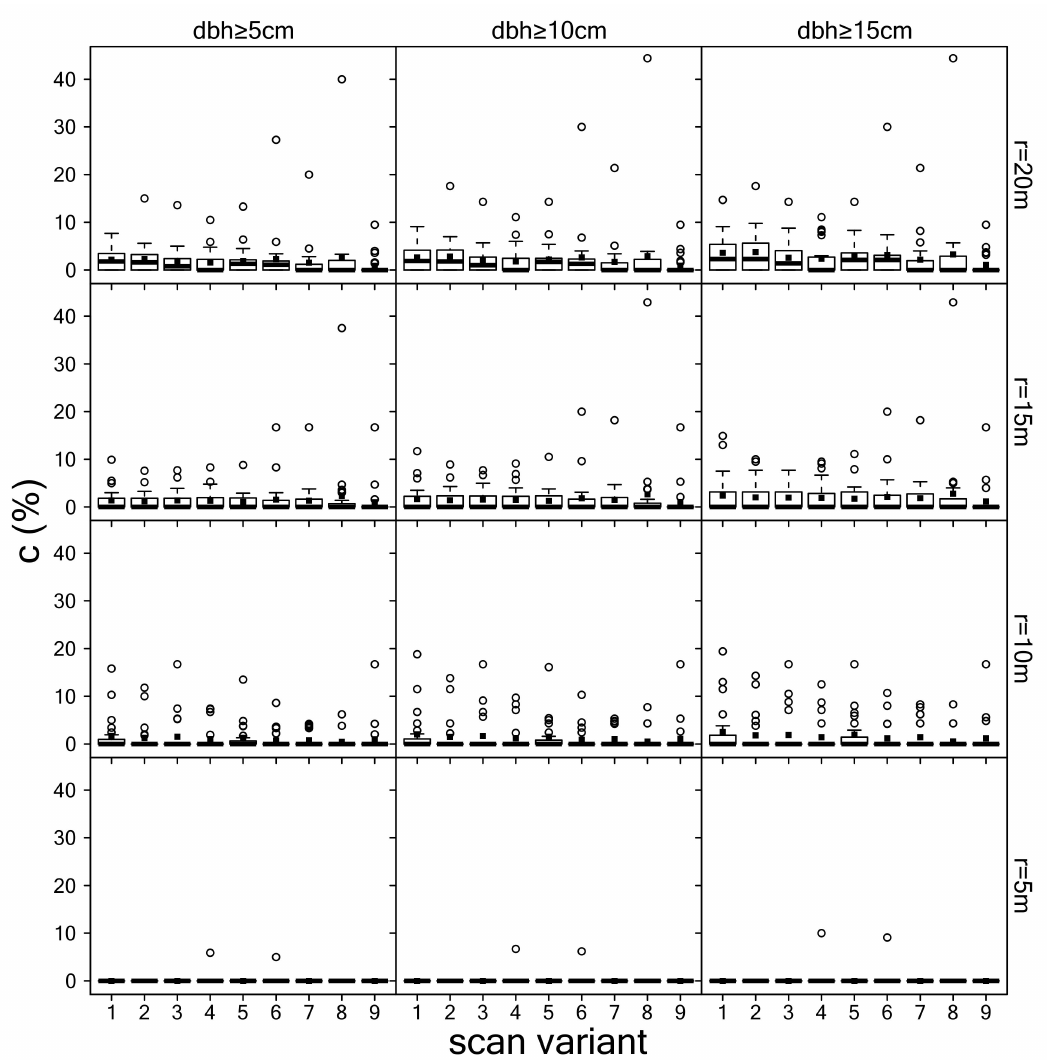
Figure 3. Commission rates for di ff erent scan variants, lower dbh thresholds, and plot radii. Black squares represent mean detection